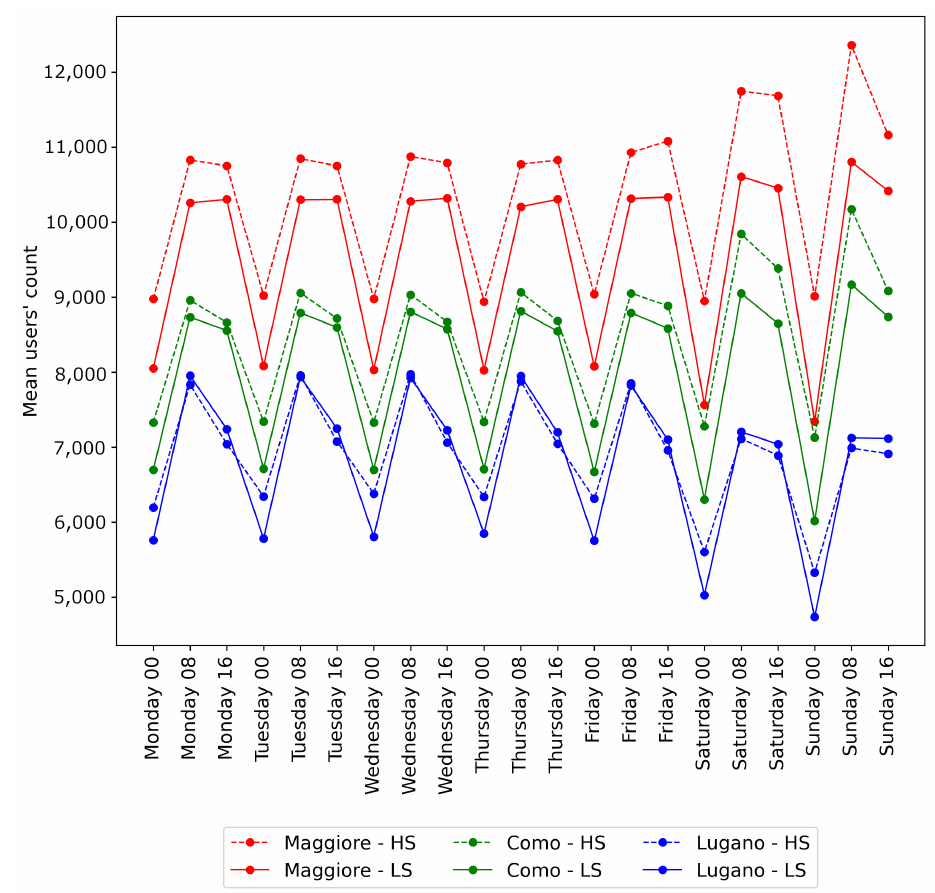
Figure 5. Variation of mean Facebook users’ count per day and hour, during high (HS) and low (LS) tourism